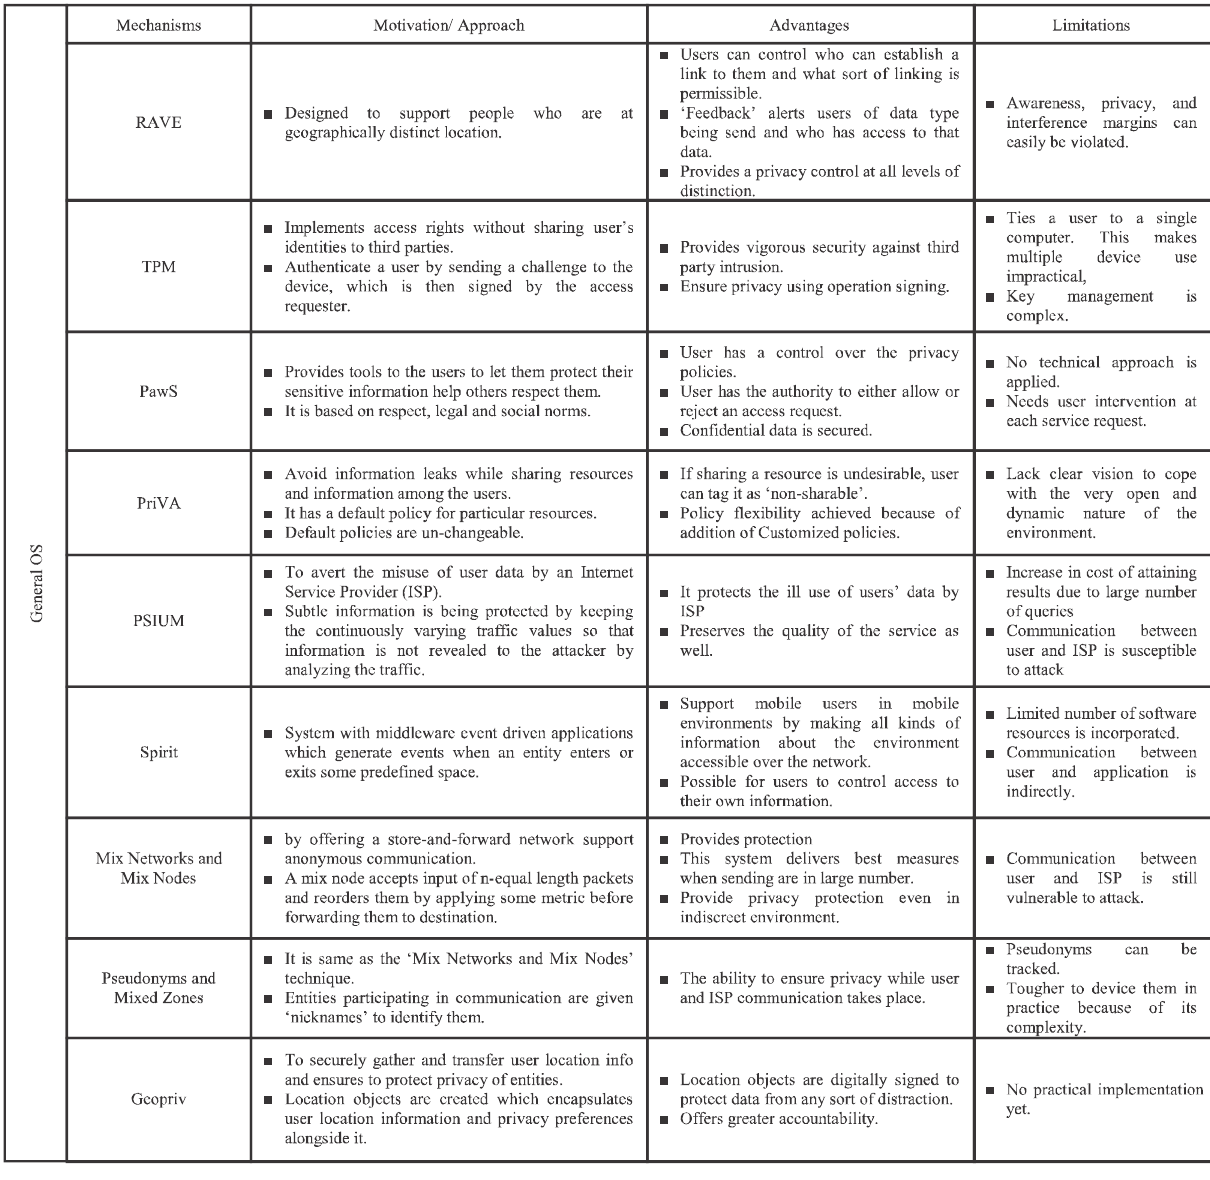
TABLE 1. SUMMARY OF EXISTING